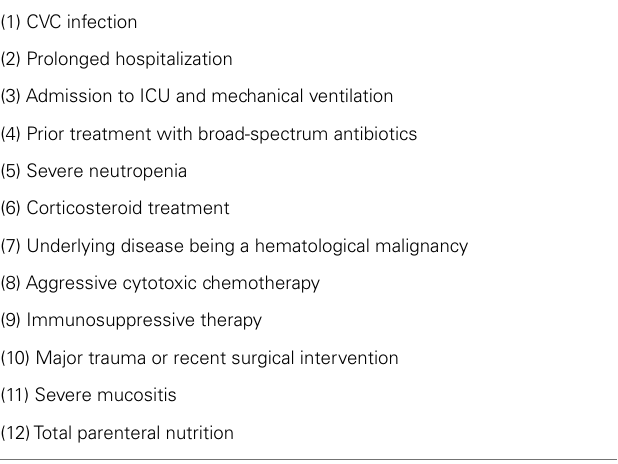
Table 3 | Risk factors for S. maltophilia bacteremia